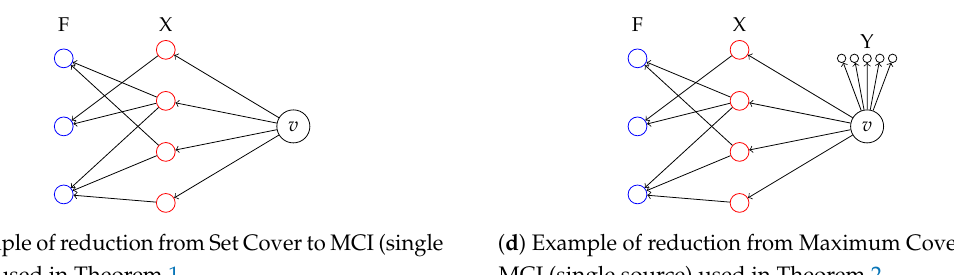
Figure 1. Examples of reductions used in Theorems 1 and